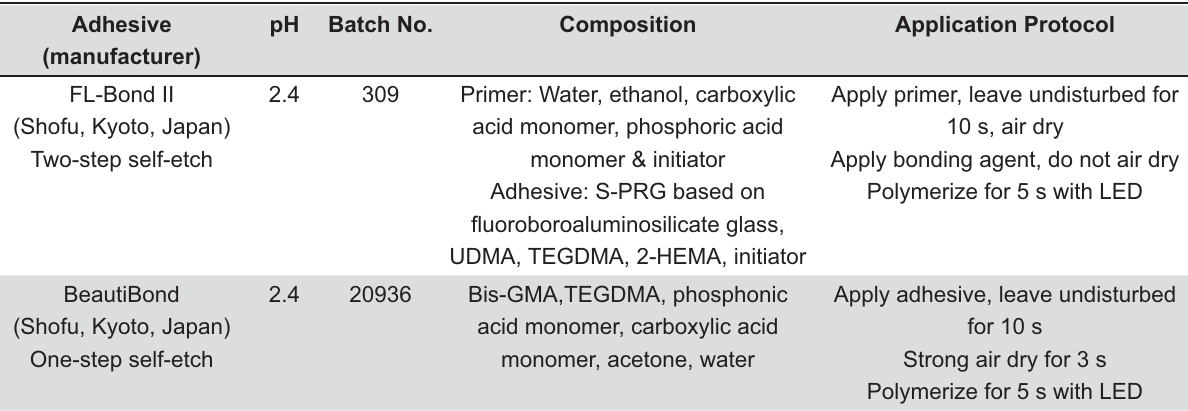
S-PRG, silica pre-reacted glass; UDMA, di(methacryloxyethyl)trimethylhexamethylene diurethane; TEGDMA, triethylene glycol dimethacrylate; 2-HEMA, 2-hydroxyethyl methacrylate; Bis-GMA, 2,2bis[4-(2-hydrogen-3-methacryloyloxypropoxy)